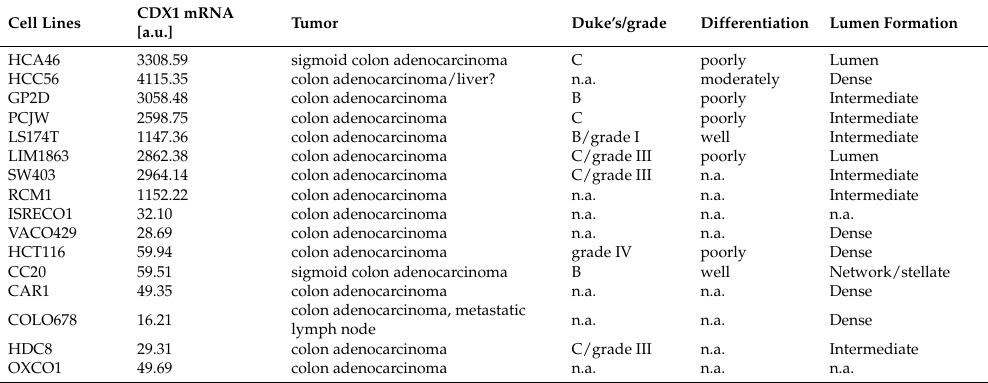
Table 1. Cell line characteristics. CDX1 mRNA expression levels are given and cell lines below expression levels of 60 units were considered CDX1 low expressing cells; a.u., arbitrary units; n.a., data not